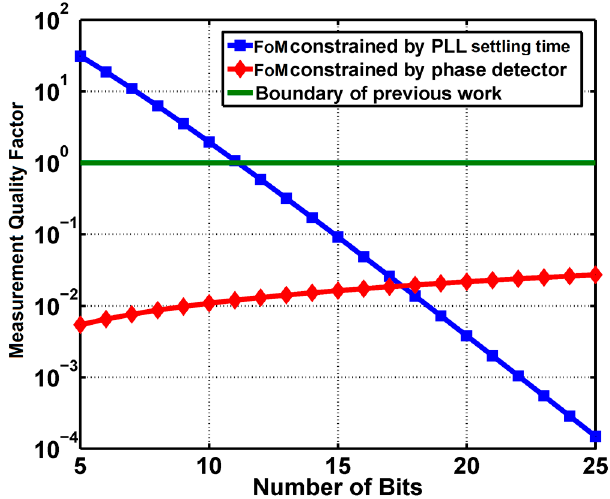
Figure 6. Measurement figure of merit FoM vs. bits number of PLL fractional divider, including FoM constrained by PLL and phase detector, and the boundary of previous work for comparison.